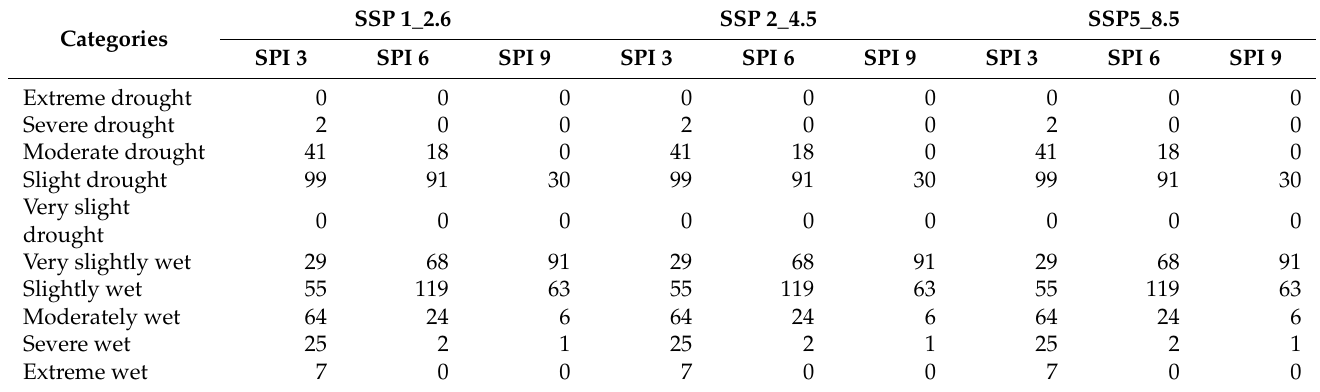
Table 4. Number of occurrences of drought and wet period in the different patterns of SPI using climate change data at Chau Doc